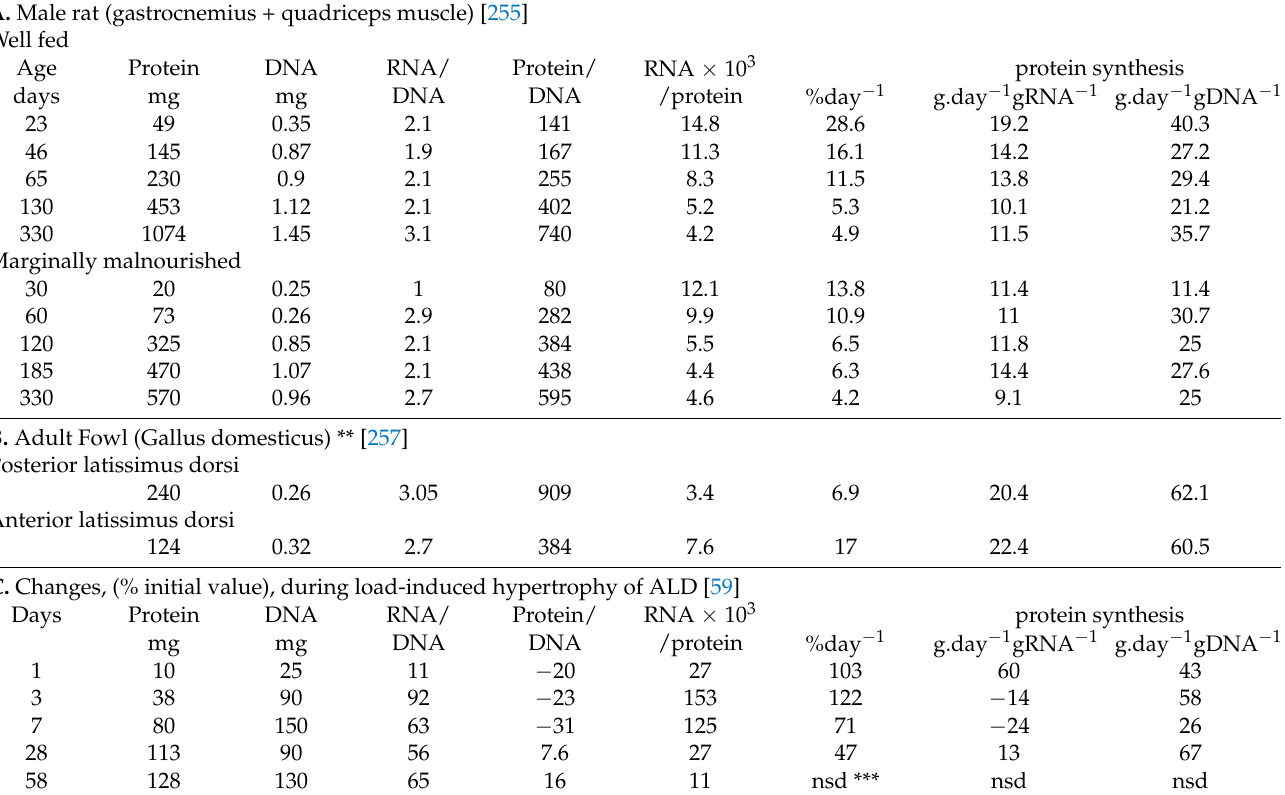
Table 2. Size of the muscle myonuclear domain (protein/DNA) and protein synthesis